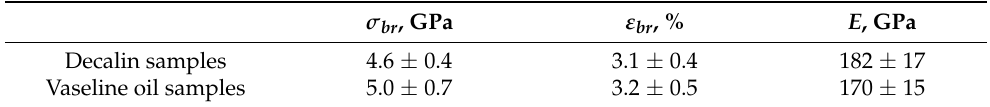
Figure 13. Stretch diagrams for 5 samples of highly oriented UHMWPE films obtained from gels in decalin ( a ) and vaseline oil ( b ). For clarity, the curves are shifted relative to each other along the x -axis. Table 3. Mechanical properties of oriented UHMWPE